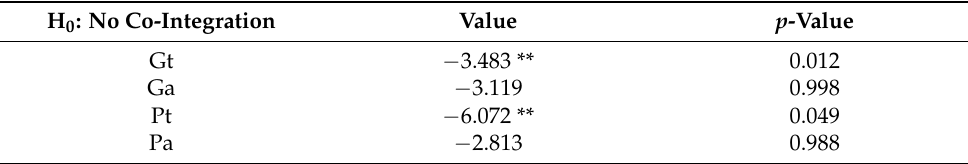
Table 7. Westerlund co-integration tests.